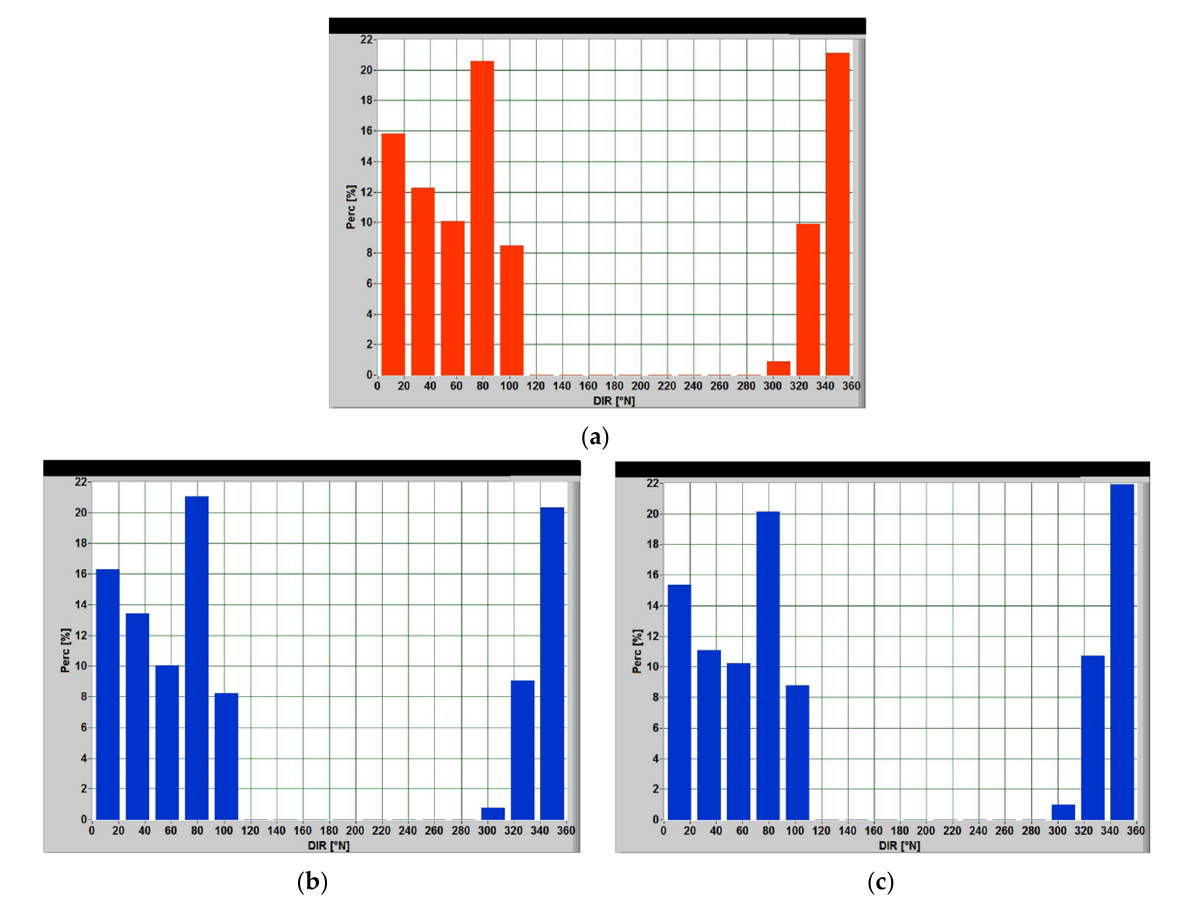
Figure 6. ( a ) Annual histogram of wave directions for angular sector of 22.5° for the Molise coast; ( b ) April to October histogram of wave directions for angular sector of 22.5° for the Molise coast; ( c ) October to April histogram of wave directions for angular sector of 22.5° for the Molise coast. Onshore directed angles were removed.